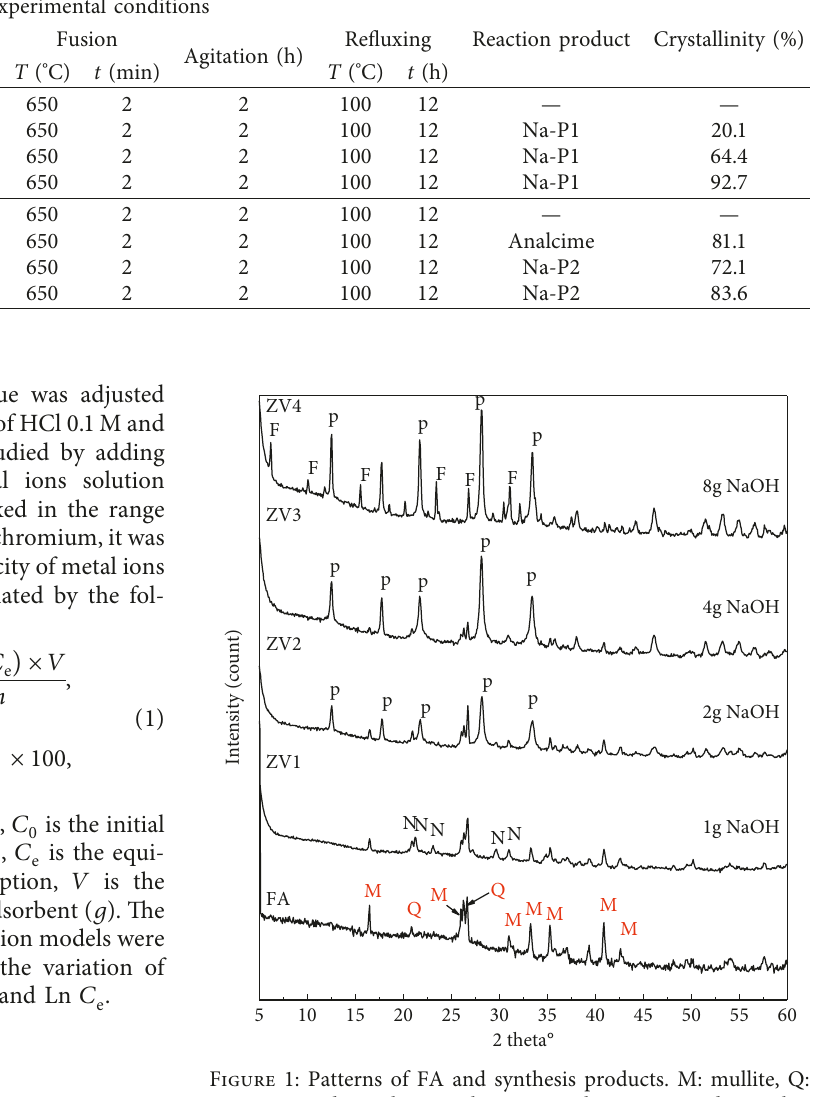
Table 2: Experimental conditions and the percentage crystallinity of the reaction products. Starting material